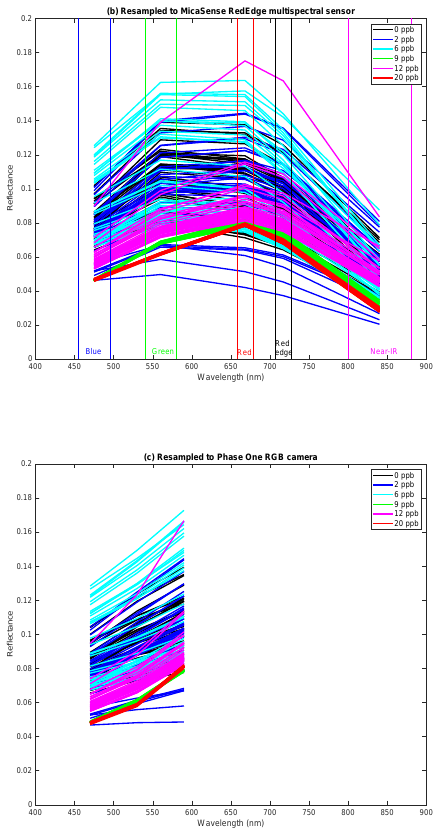
Figure 3. ( a ) Original field spectra for turbidity from 55-60 NTU and six different levels of dye concentration. ( b ) Spectra resampled to the band passes of the MicaSense RedEdge multispectral sensor. The band passes for the five bands of this instrument are indicated by vertical lines and labeled along the horizontal axis. ( c ) Spectra resampled to the band passes of the Phase One RGB